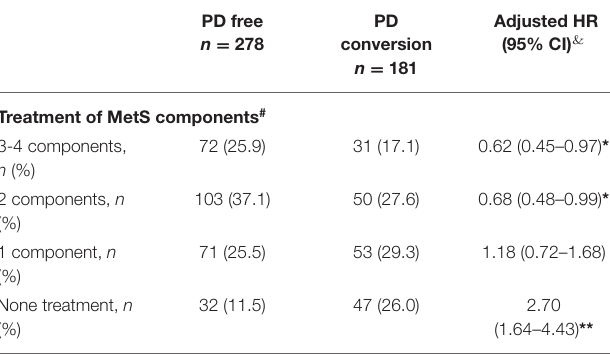
TABLE 4 | Treatment of MetS with risk of PD